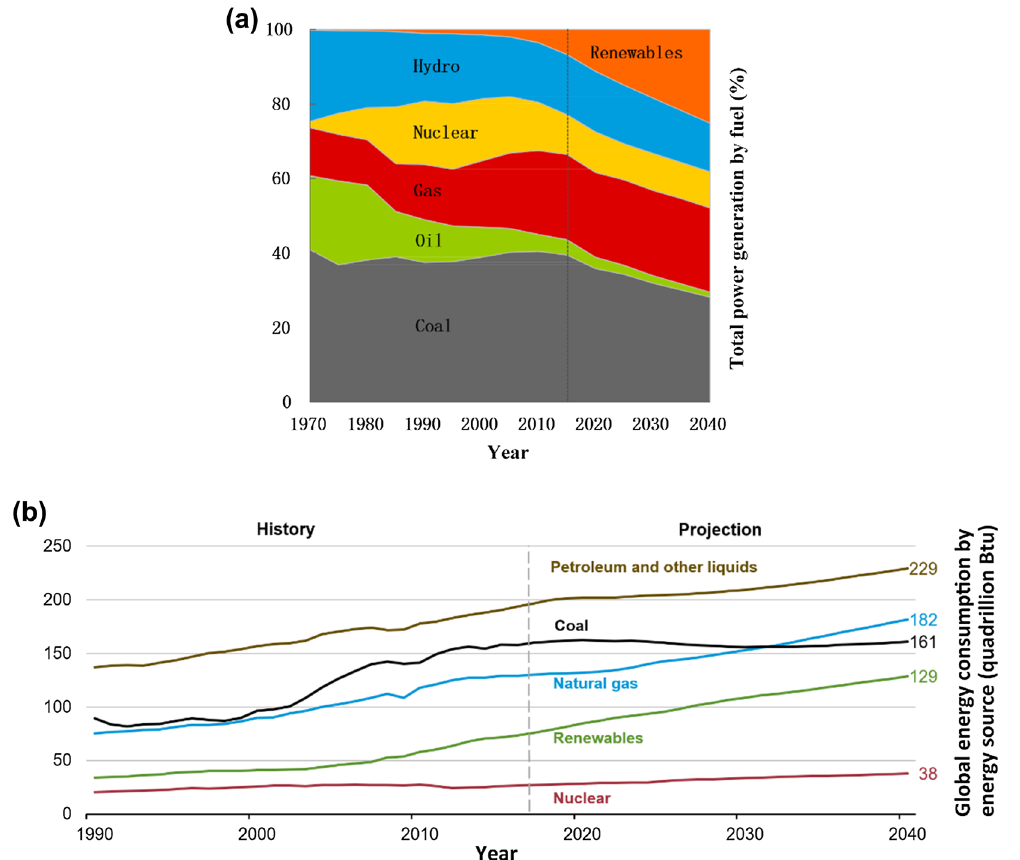
Fig. 2 a Total power generation by fuel (%) (BP 2018a), and b global energy consumption by energy source (quadrillion Btu) (EIA